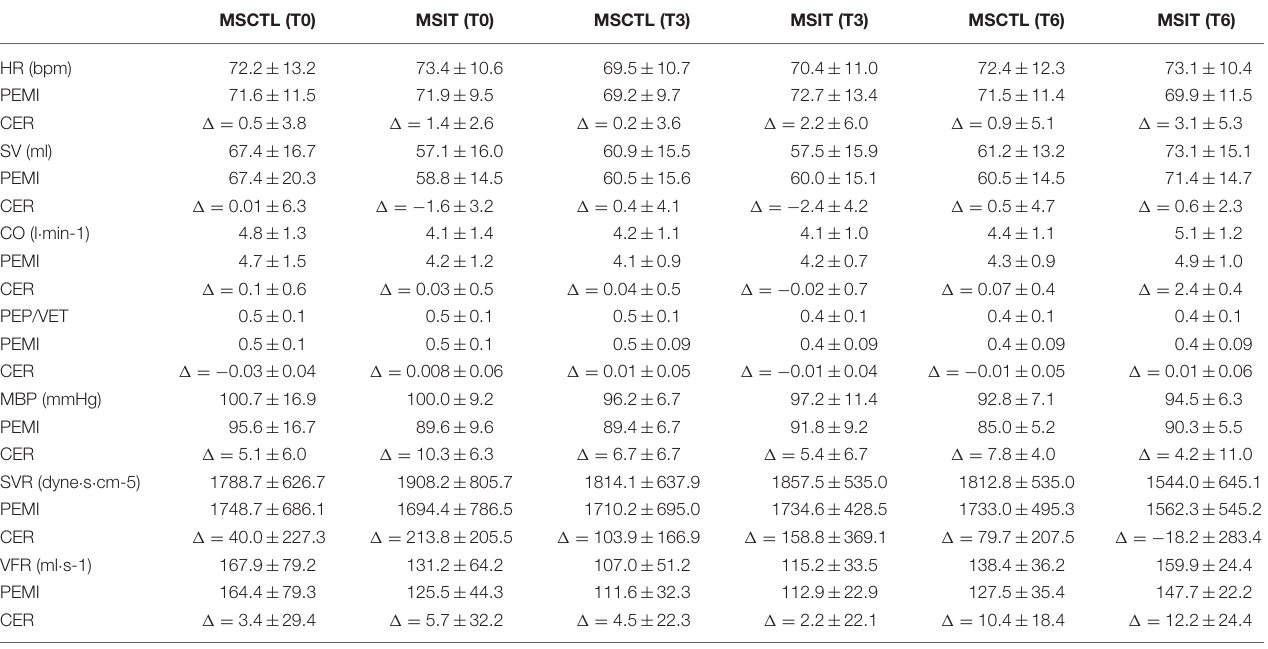
TABLE 3 | Hemodynamic data at the third minute of recovery of post-exercise muscle ischemia (PEMI) and control exercise recovery (CER) tests at T0, T3, and T6 in both control Multiple Sclerosis group (MSCTL, n = 10) and in the intervention Multiple Sclerosis group (MSIT, n = 11)